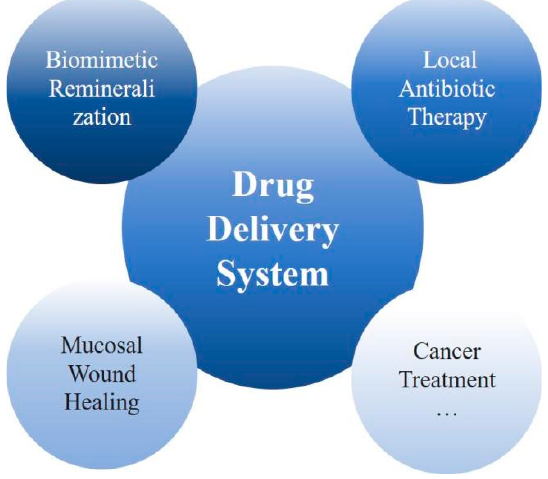
Figure 7. Drug delivery system based on hydrogel application for oral diseases.